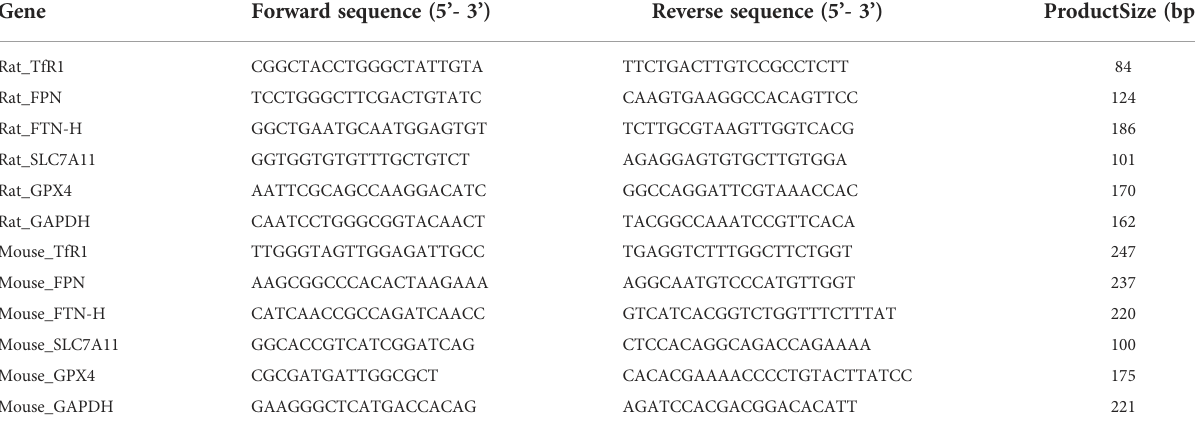
TABLE 1 qPCR Primer